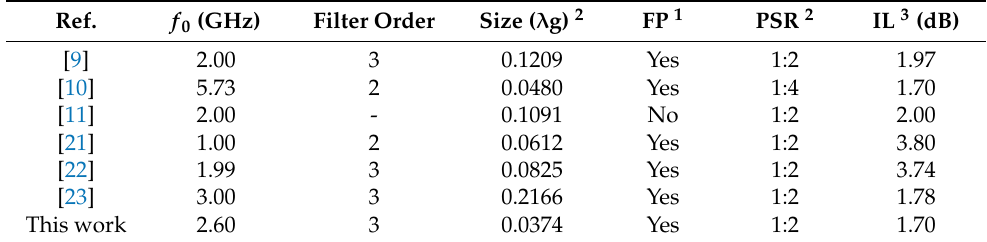
Table 2. Calculated circuit model design parameters.